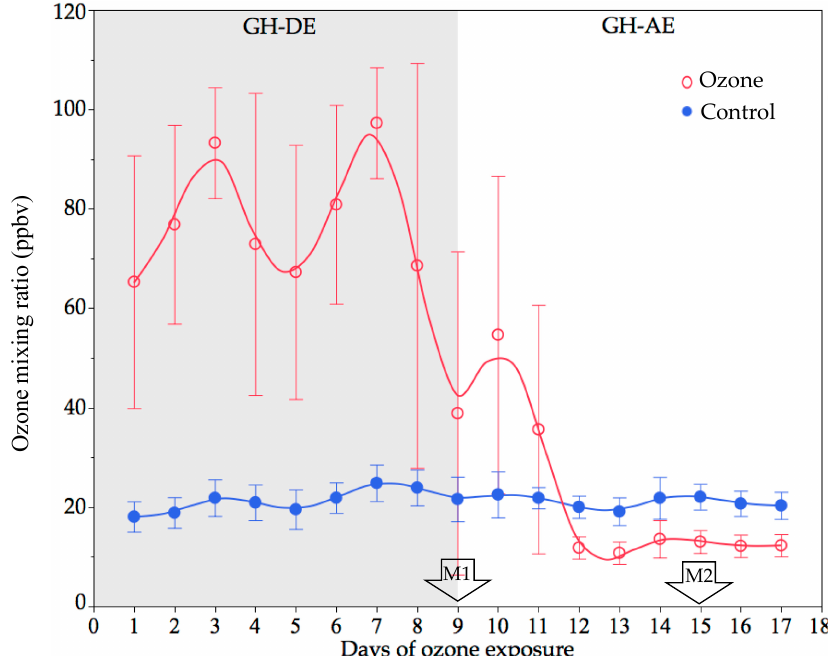
Figure 1. GH O 3 concentration. O 3 mixing ratios in ozone and control GHs during O 3 exposure (GH-DE) and after O 3 exposure (GH-AE). Values represent averages over all sensors (mean ± SD). Physiological measurements: M1 at GH-DE and M2 at GH-AE.